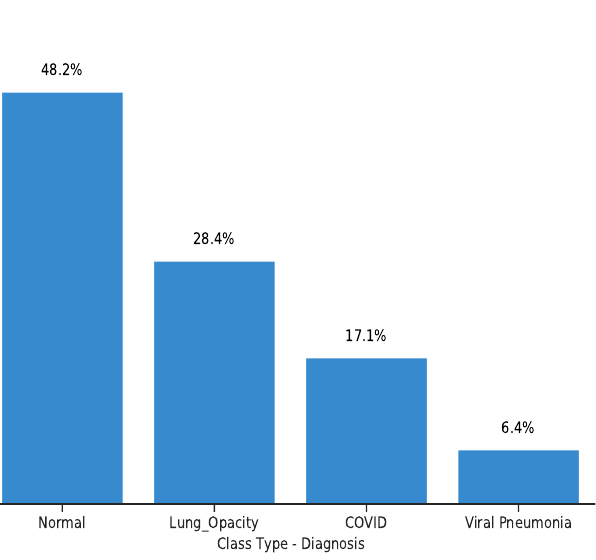
Figure 3. A histogram of the distribution of the X-ray images per class. Healthy/Normal has the largest numbers of data-points, representing 48.2% per cent of the dataset followed by Lung Capacity, COVID-19then viral pneumonia